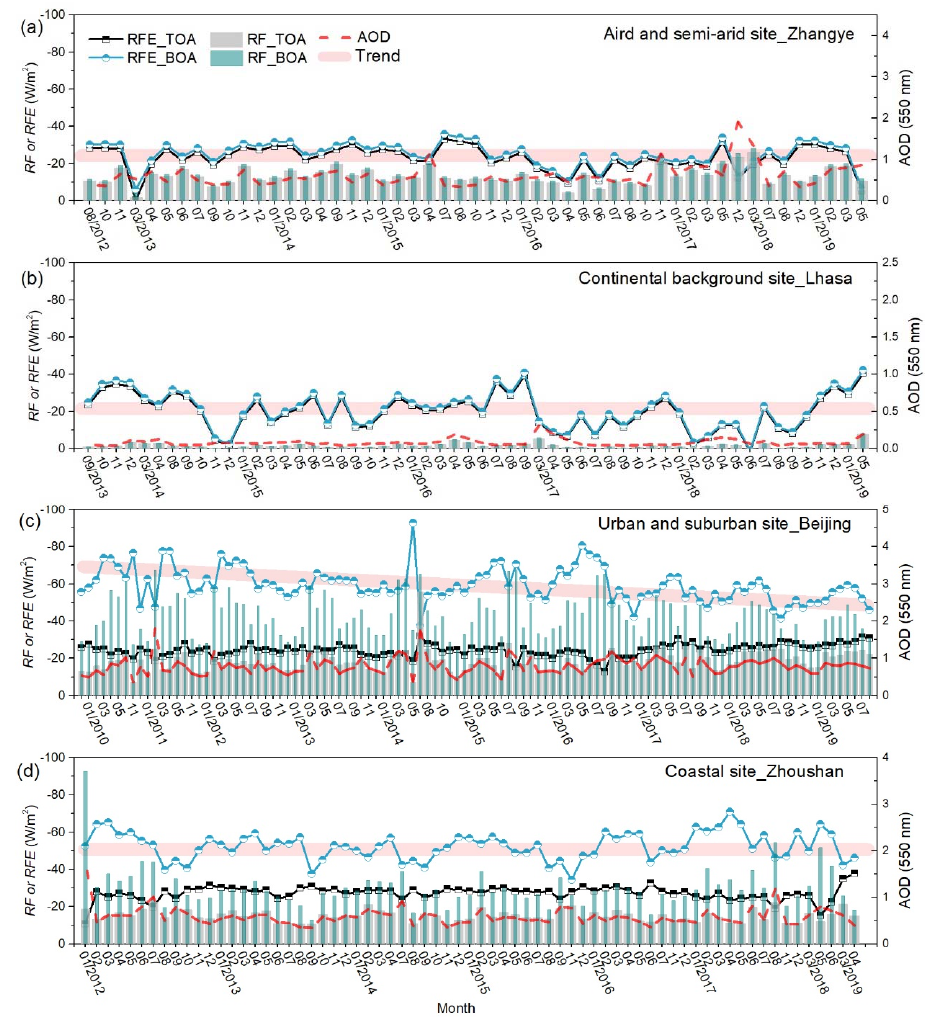
Figure 6. Monthly average aerosol RF and RFE and corresponding AOD at 550 nm at four types of sites: ( a ) arid and semi-arid site Zhangye; ( b ) continental background site Lhasa; ( c ) urban and suburban site Beijing; ( d ) coastal site Zhoushan. Table 4. Comparison with previous reports on long-term average aerosol radiative forcing e ffi ciencies at the four types of sites.